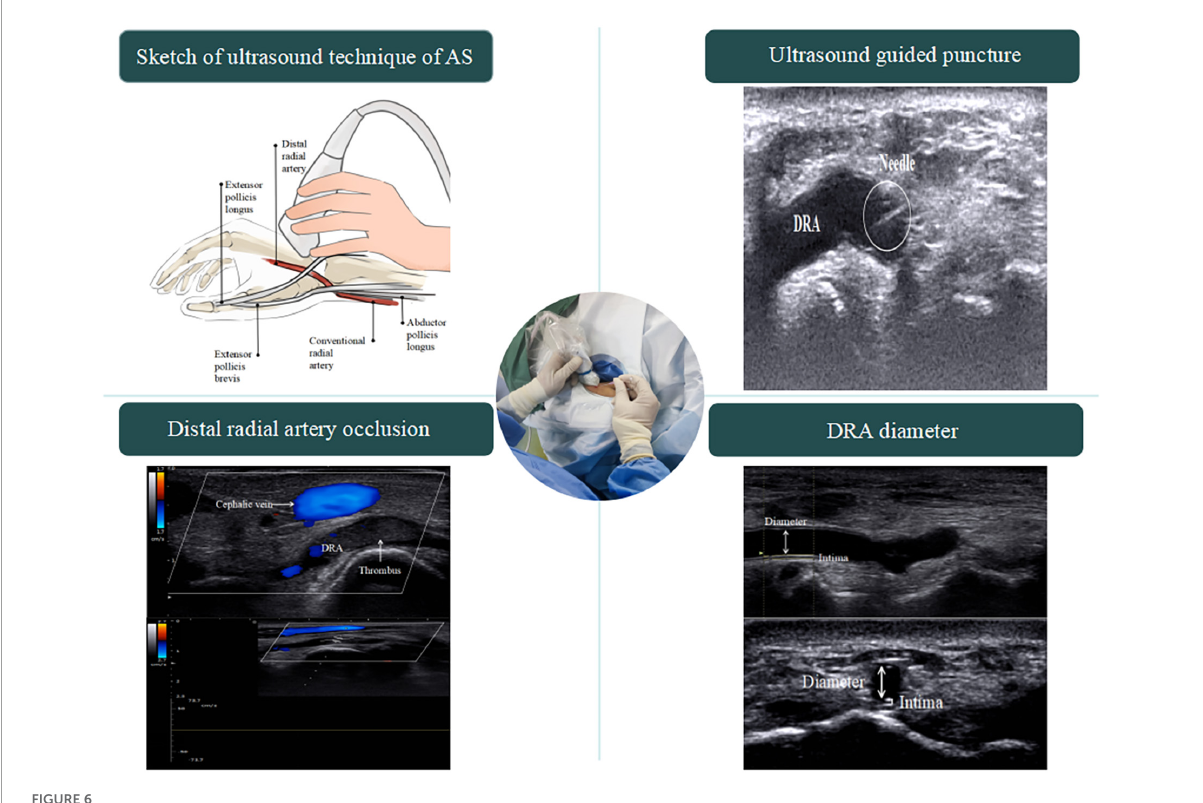
FIGURE6 Central